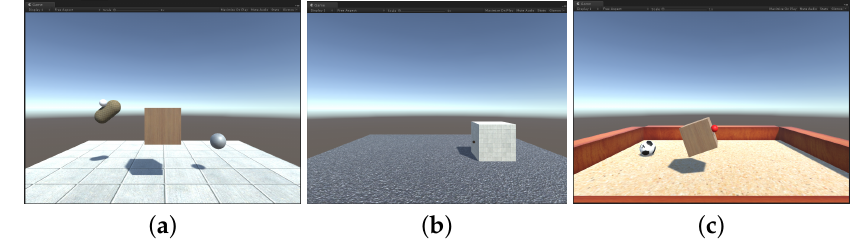
Figure 10. ( a ) Shape exploration, ( b ) friction forces, and ( c ) shape manipulation